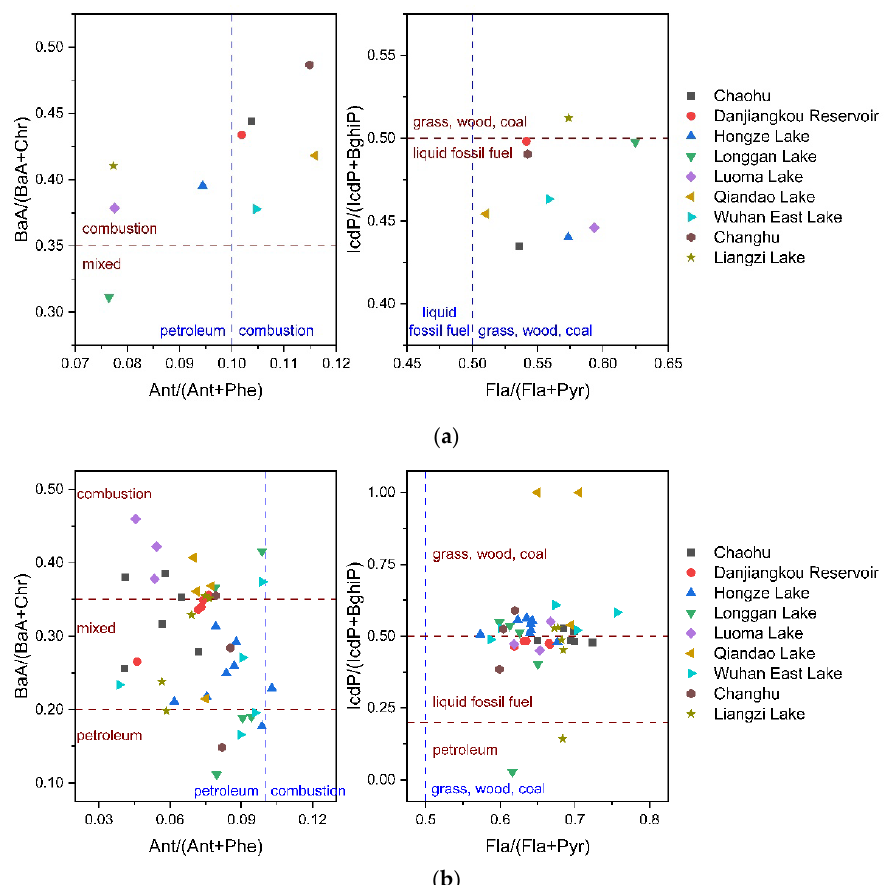
Figure 8. PAH diagnostic ratios of Ant/(Ant+Phe), BaA/(BaA+Chr), Fla/(Fla+Pyr) and IcdP/(IcdP+BghiP) in soil and plant samples. ( a ) Diagnostic ratios in soil. ( b ) Diagnostic ratios in